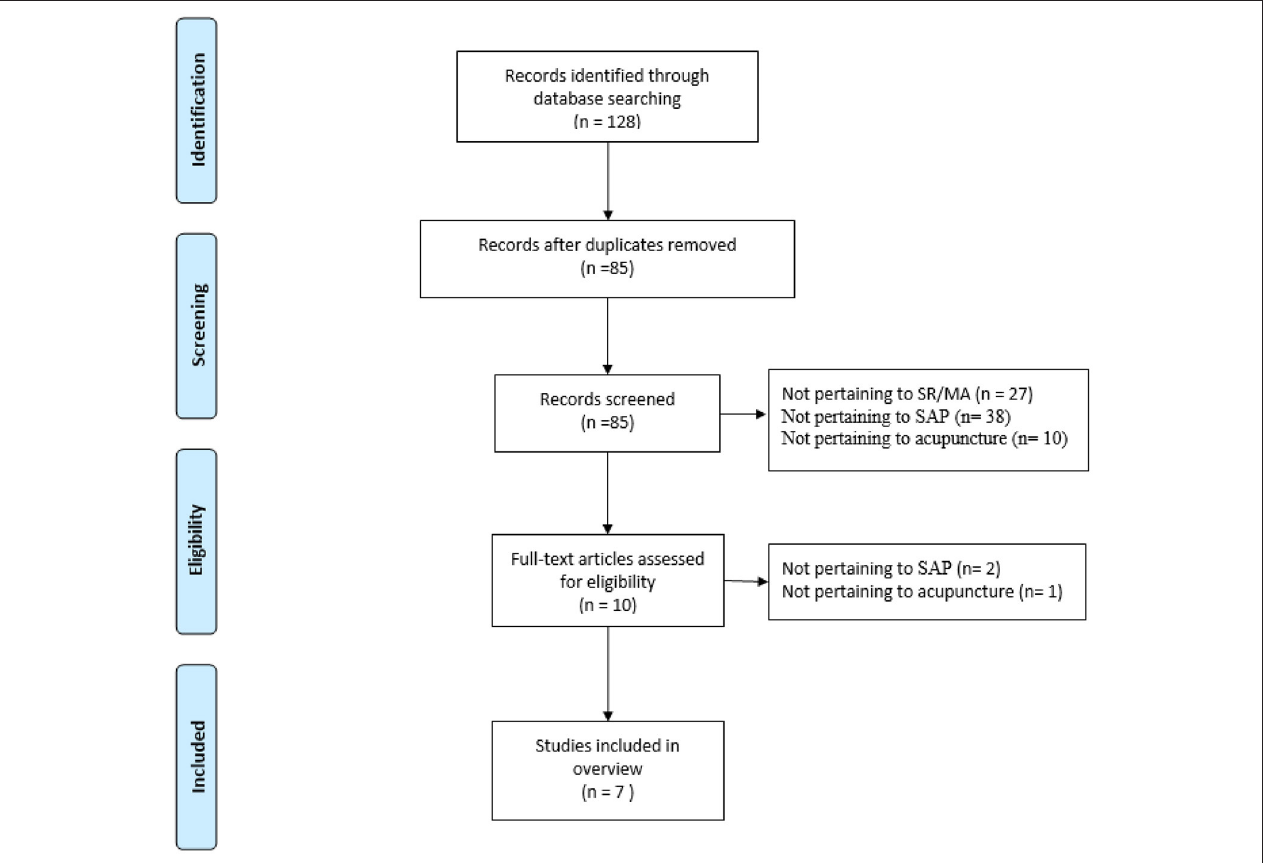
FIGURE 1 | Flow diagram of the review selection